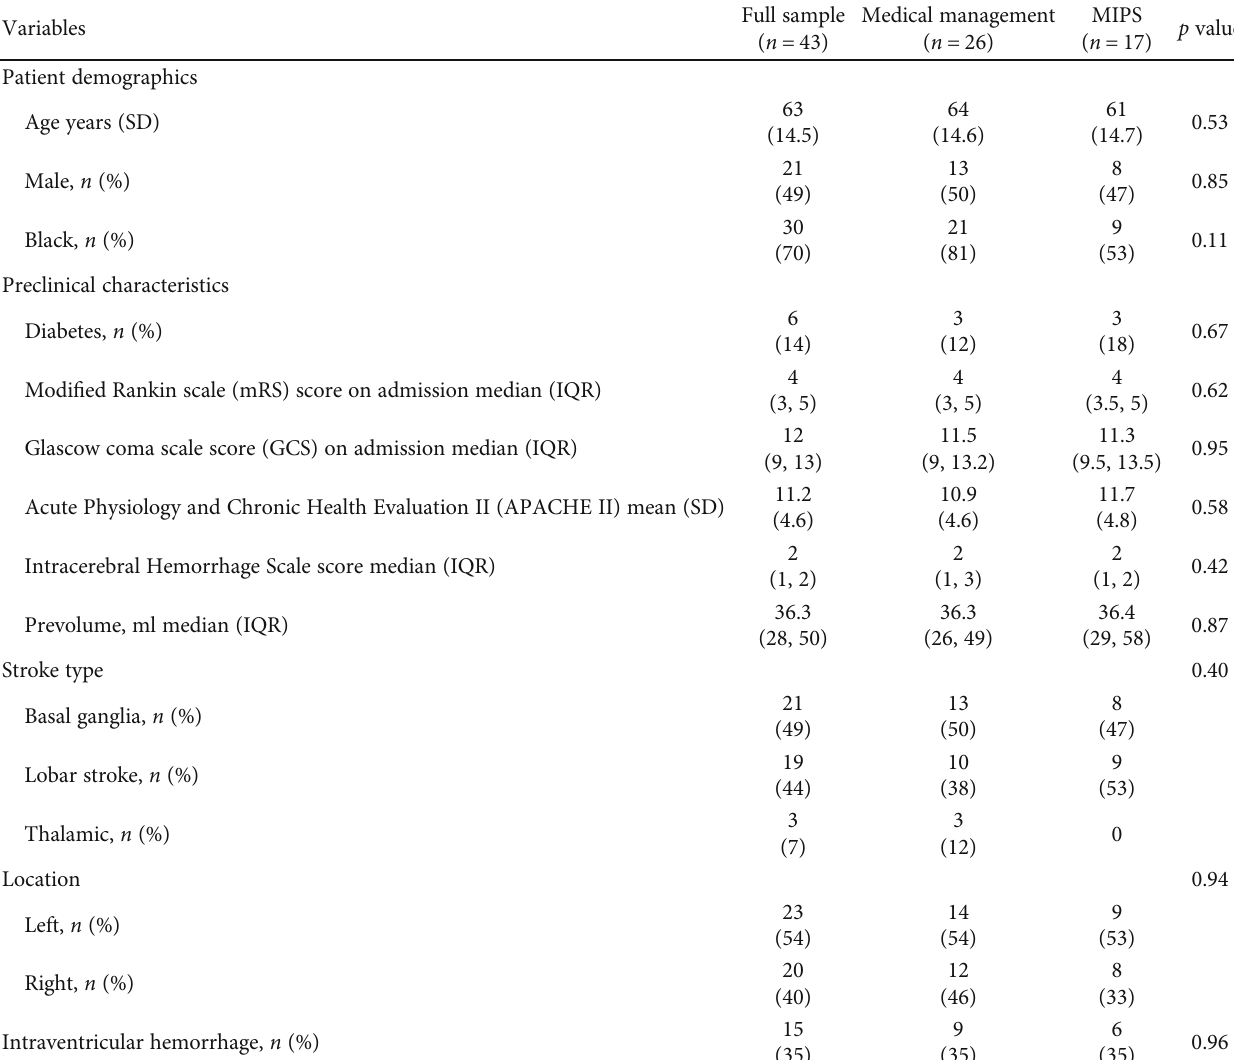
Table 1: Demographic and preclinical data for the full sample and by treatment group: medical management versus minimally invasive parafascicular surgery